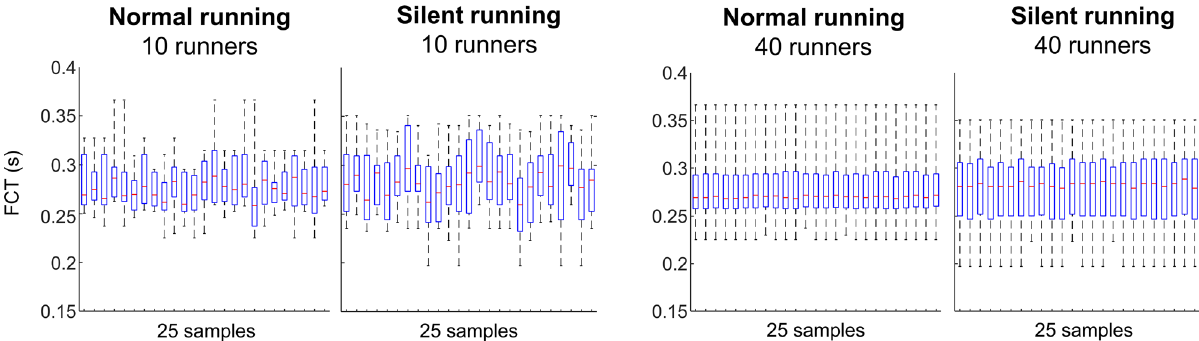
Figure 5. Illustration of 25 subsamples containing foot contact time (FCT) from 10 (left) and 40 runners (right) during both normal and silent running. Box plots represent 25th and 75th percentiles, and data range ( dashed vertical lines ). The 25 subsamples were randomly selected from 100,000 paired samples generated for further